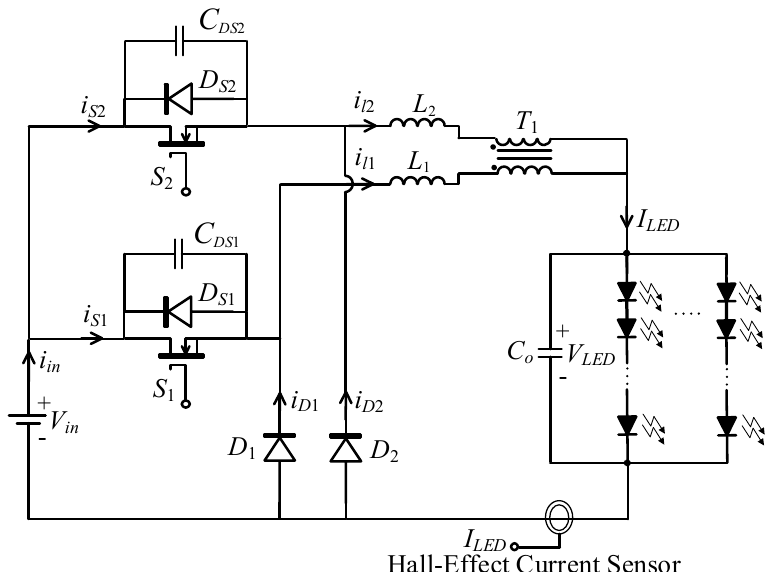
Figure 1. Circuit topology of the proposed LED driver.